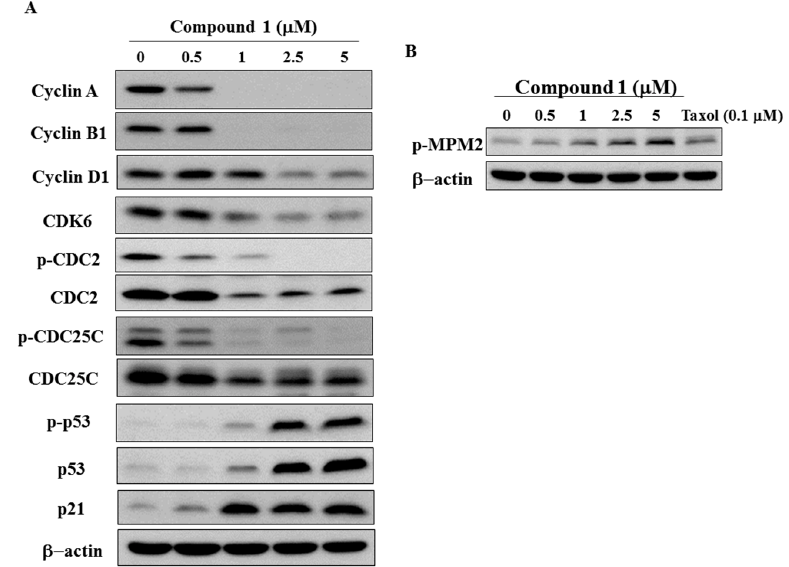
Figure 4. Effects of compound 1 on cell cycle-regulatory proteins. ( A ) Western blotting analysis of the phosphorylation/expression of cell cycle-regulatory proteins, cyclin A, cyclin B1, cyclin D1, CDK6, CDC2, CDC25C, p53, and p21. MCF-7 cells were exposed to compound 1 at the indicated concentrations for 48 h; and ( B ) the effect of compound 1 on the expression of phosphorylated MPM2. Treatment with taxol at 0.1 μ M was used as a positive control.